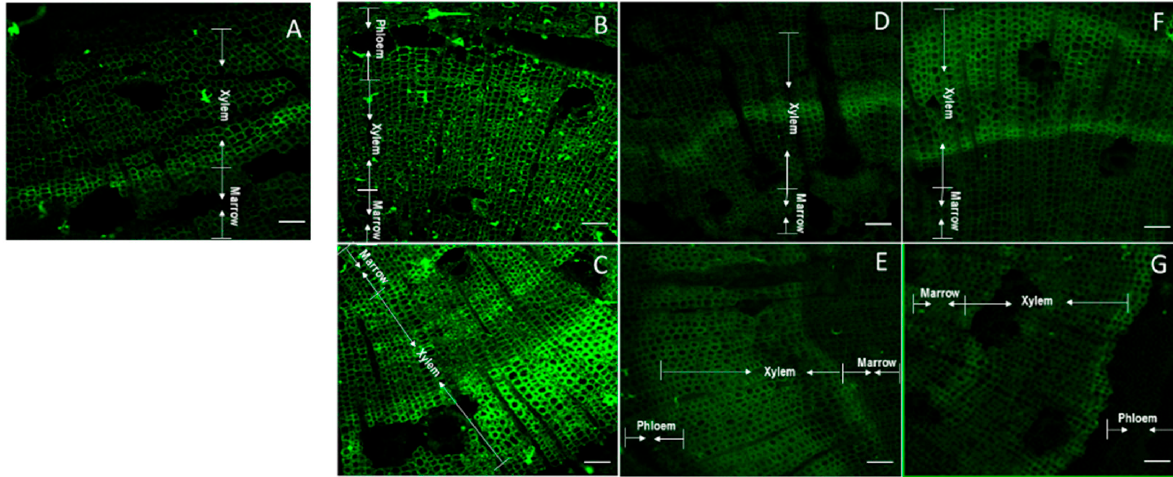
Figure 4. Confocal microscopy of thin sections of one year old radiata pine seedlings incubated with JIM7 antibody and Alexa Fluor. Control stem (non-inclined) ( A ). Upper side of inclined stems after 2.5 h ( B ), 10 h ( D ) and 24 h ( F ). Lower side of inclined stems after 2.5 h ( C ), 10 h ( E ) and 24 h ( G ). Arrows indicate the section within the cuts corresponding to marrow, xylem and phloem. Scale of 100 µ